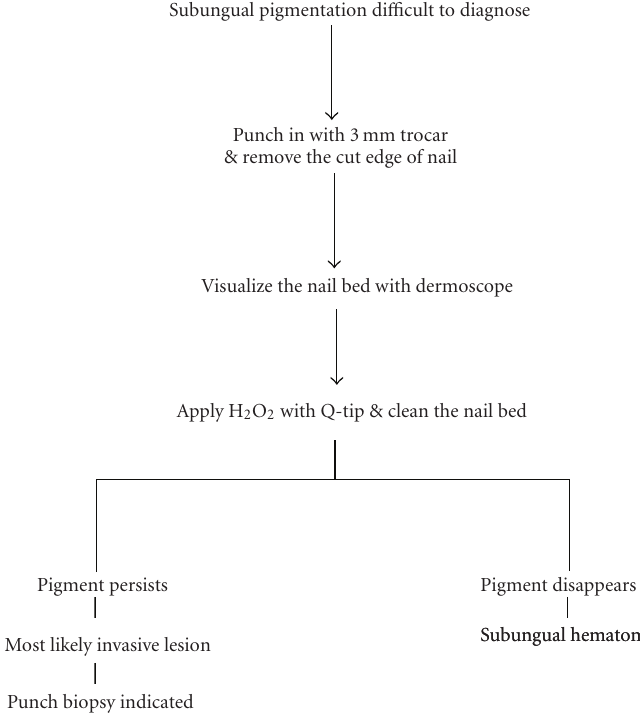
Figure 7: Flow chart of modified Haneke